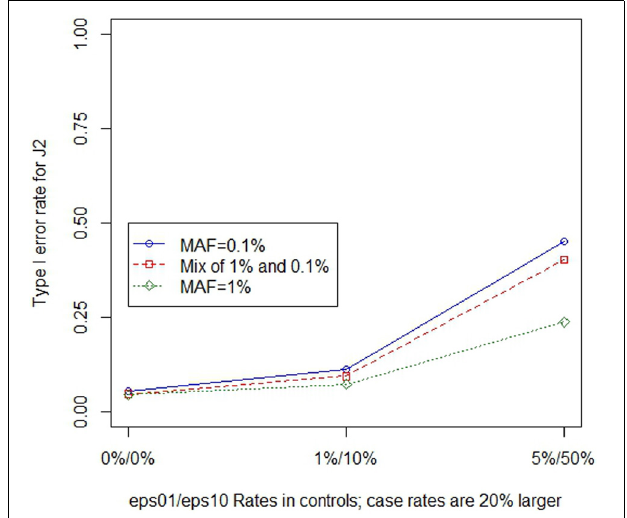
FIGURE 2 | Type 1 error rate for J 2 in the presence of differential genotype errors at different MAF. As differential error rates increase, the